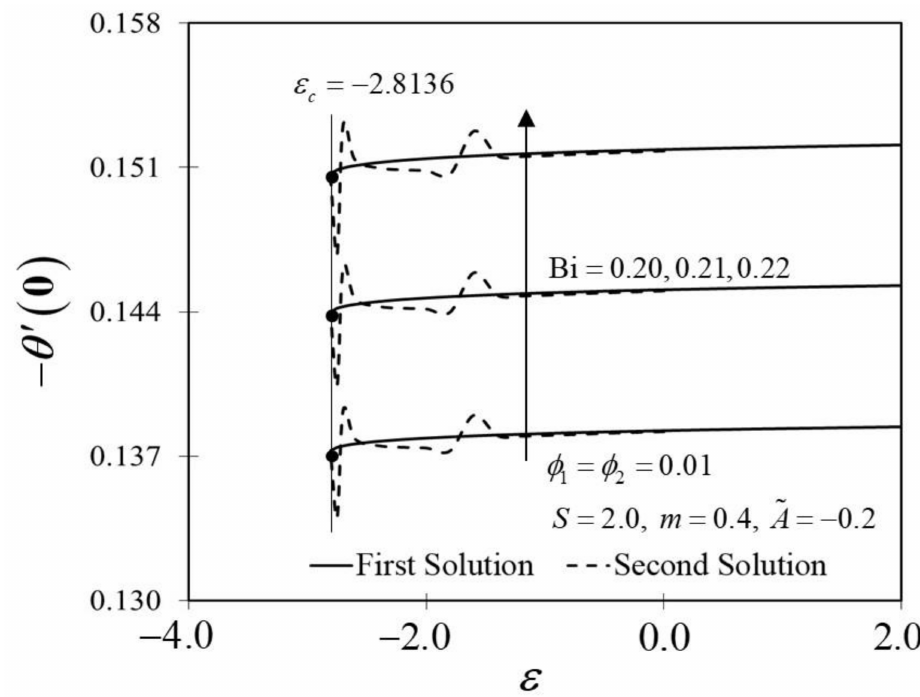
Figure 14. Trend of − θ (cid:48) ( 0 ) with ε and assorted